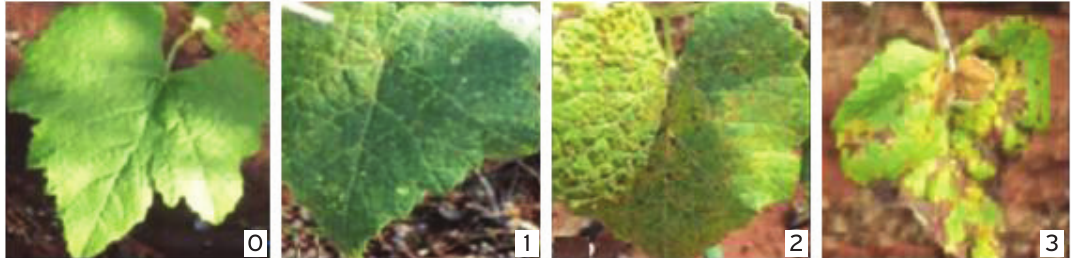
0 Figura 2. Escala utilizada para a avaliação da severidade de ferrugem em folhas de videira no campo; 0 = folhas sadias, 1 = baixa, 2 = média e 3 = alta severidade de ferrugem. Selvíria (MS), 2012.